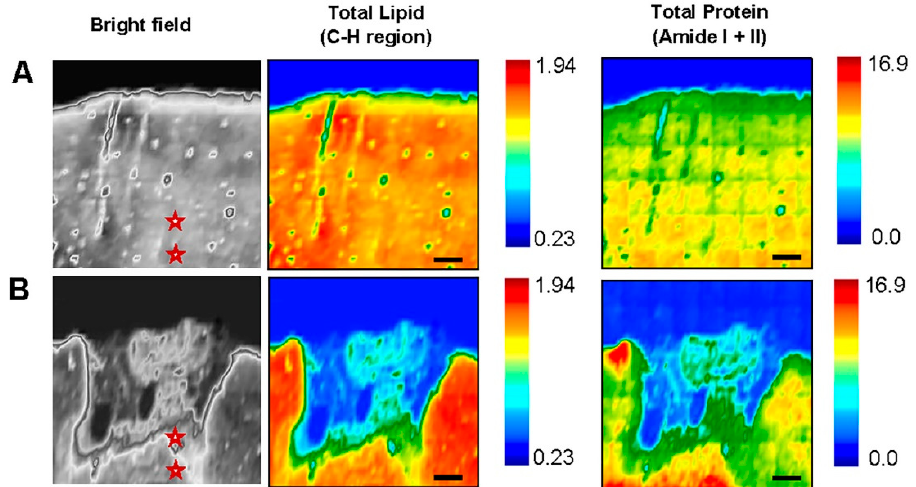
Figure 2. Fourier Transform Infrared (FTIR) biochemical images of Total Lipid (C-H region) and Total Protein (Amide I + II) on ( A ) Contra-lesional and ( B ) Ipsi-lesional hemisphere of nine weeks post stroke brain tissues. The images show significant changes in distribution of lipid and protein at peri-infract zone (PIZ) and white matter (WM). The stars in the bright field images shows where the spectra where taken. The color bars showing the intensity of the biochemical components—red as maximum and blue as minimum. Scale bar = 100 µm.